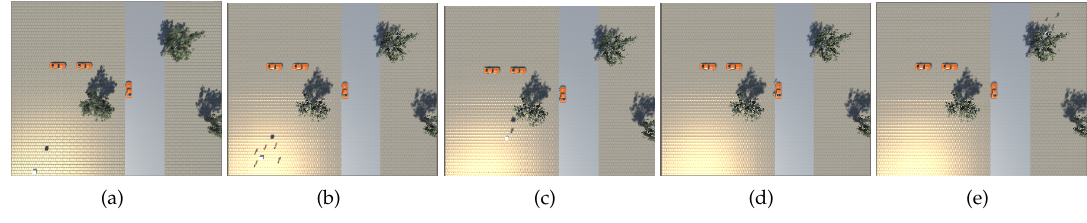
Figure 5. Image sequence of a group of pedestrians moving from the bottom left of the environment ( a ) to the top right ( e ). The image is captured by a top view camera during the simulation to demonstrate the tracking behaviour of our network.